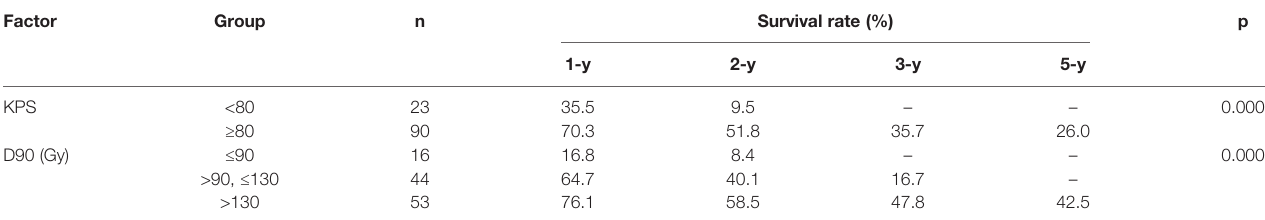
TABLE 4 | Subgroup analysis of overall